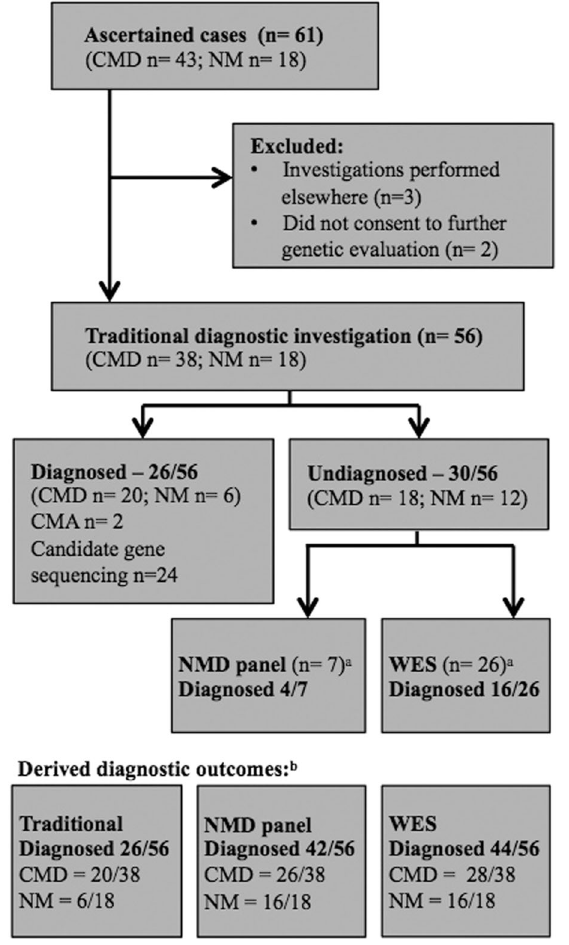
Fig. 2 Case ascertainment and investigation. Ascertainment and diagnostic outcomes for the combined CMD and NM cohorts. a Three patients were investigated using only the NMD panel, four patients had both NMD panel and WES, and one sibling had neither NMD panel or WES while investigations were performed on the proband. b Diagnostic outcomes for the NMD panel are derived from data obtained from WES and based on previous studies comparing the diagnostic ef fi cacy of WES and NMD panel testing, given only a small subset ( n = 4) were investigated using both WES and the NMD panel. An assumption is made that patients diagnosed using candidate gene sequencing would also be diagnosed using CMA plus NMD panel or WES. CMD congenital muscular dystrophy,